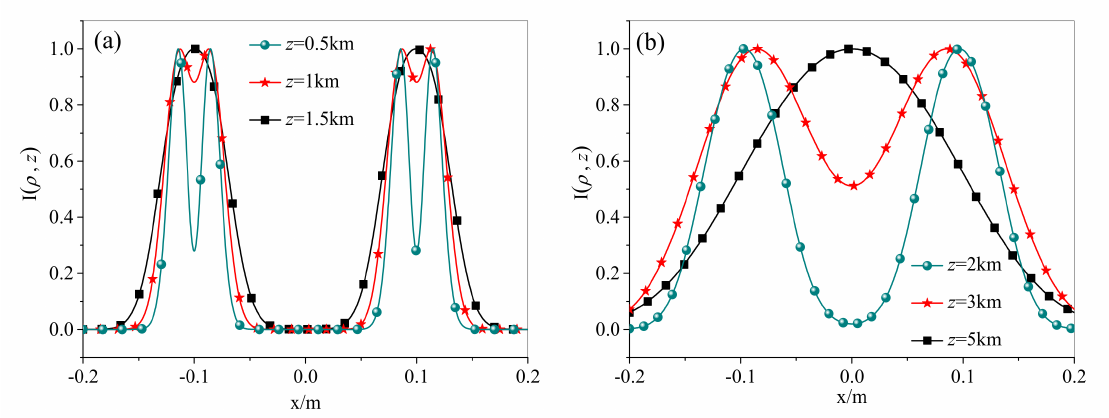
Figure 3. Intensity distribution profiles of the RPLPCV beam array propagated through non-Kolmogorov turbulence for different propagation distances: ( a ) z = 0.5 km, 1 km, 1.5 km; ( b ) z = 2 km, 3 km, 5